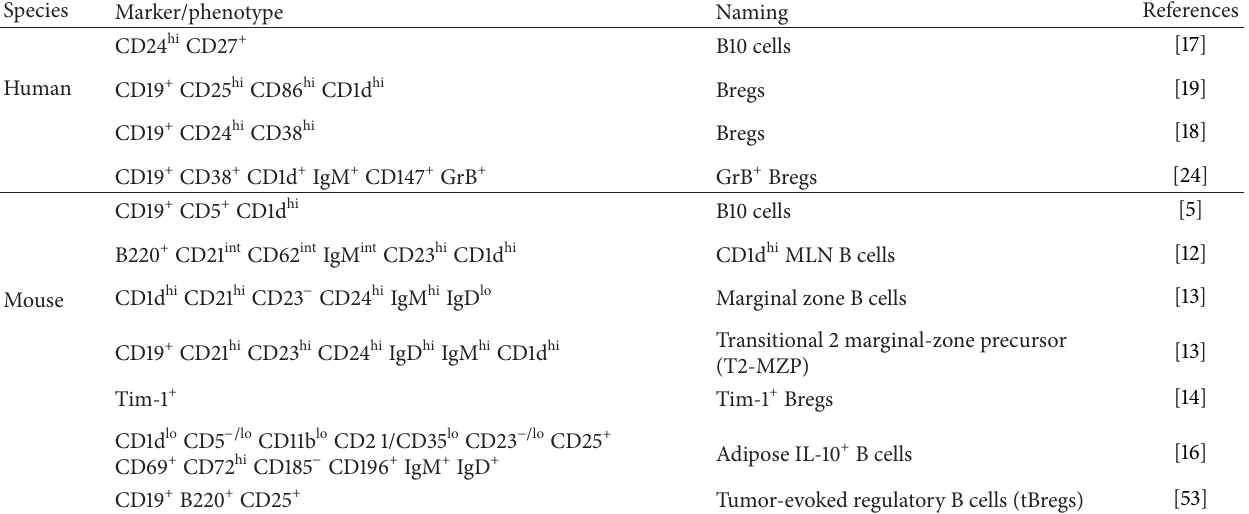
Table 1: The immunophenotype and naming of the regulatory B cells in mouse and